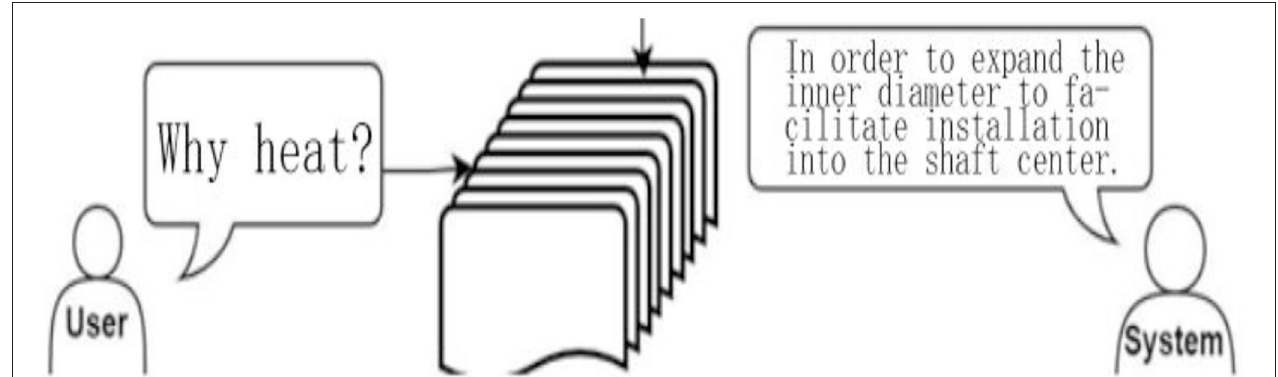
FIGURE 9 | Schematic diagram of the dialogue